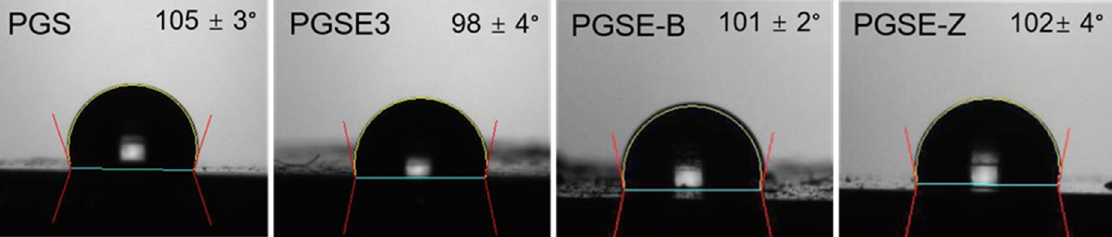
Figure 6. Representative photographs of water droplets on the surface of PGS, PGSE3, PGSE-B, and PGSE-Z and their associated contact angles ( n = 6).